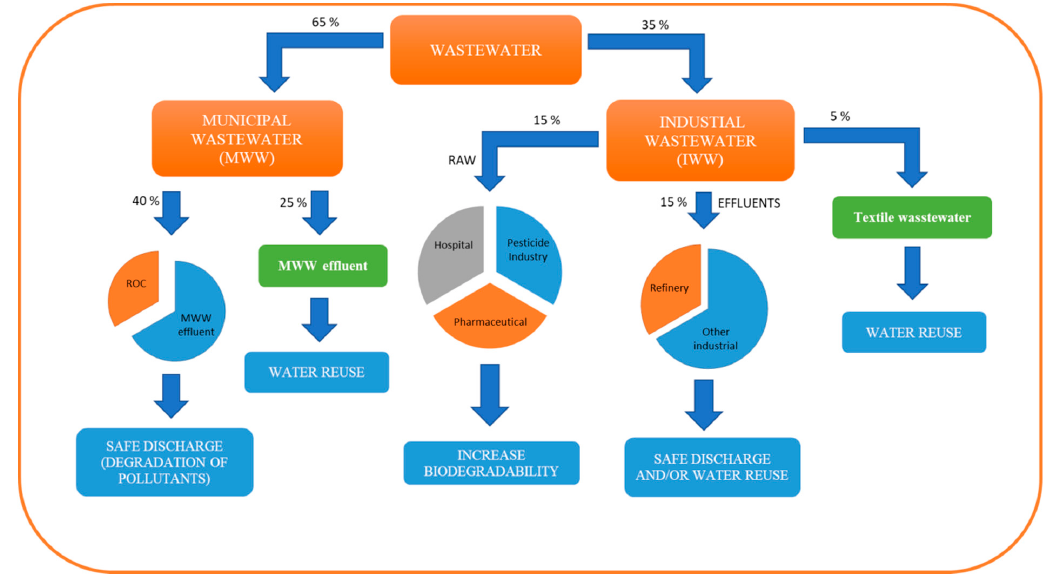
Figure 2. Schematic presentation of types of wastewater used for detoxification by photo-Fenton and/or UV/H 2 O 2 /real waste water (RWW) in the last ten years. UV / H 2 O 2 / real waste water (RWW) in the last ten